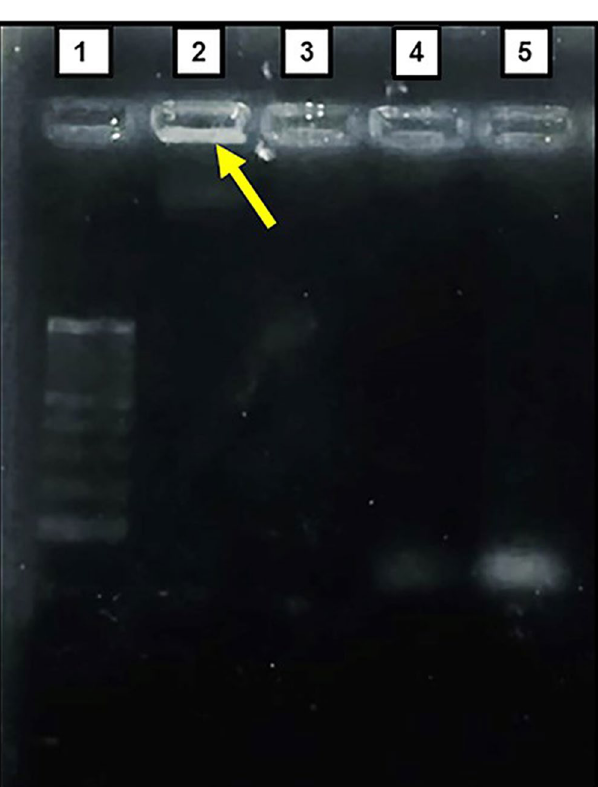
Figure 4. Confirmation of NPs-aptamer conjugation. 1: ladder (100 bp), 2: PLA-PEG-Apt/DOX NPs, 3: PLA- PEG, 4: mixture of aptamers and PLA-PEG, 5: free aptamer (Apt). Original gel is presented in Supplementary Fig.